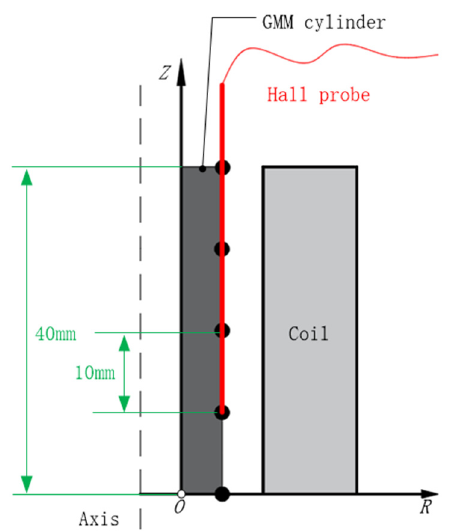
Figure 21. Magnetic field intensity measuring point.